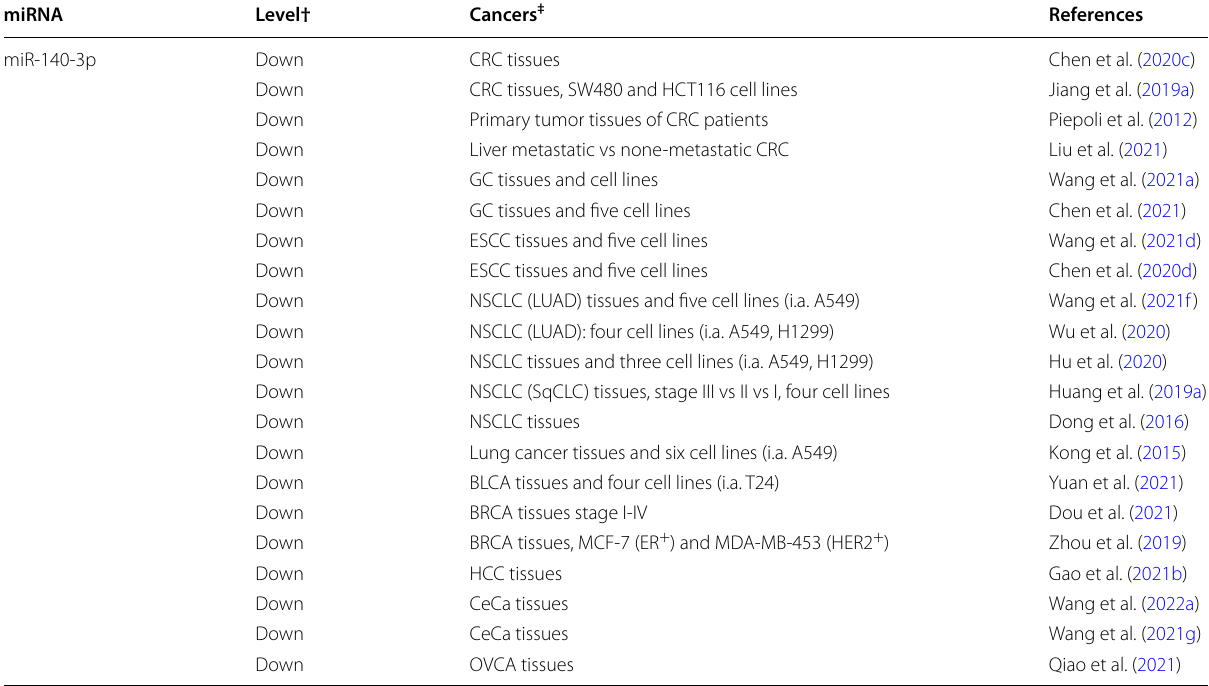
Table 4 Expression levels of miRNAs targeting i.a. TYMS mRNA in